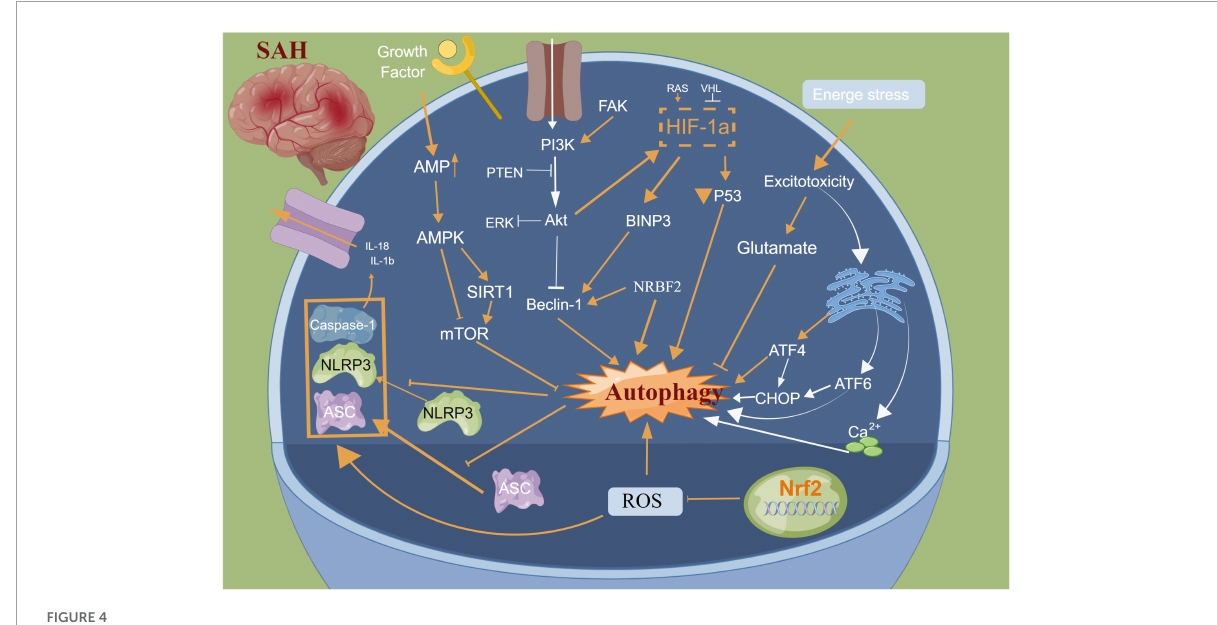
FIGURE4 Molecular mechanisms of autophagy from subarachnoid hemorrhage to early brain injury (EBI).